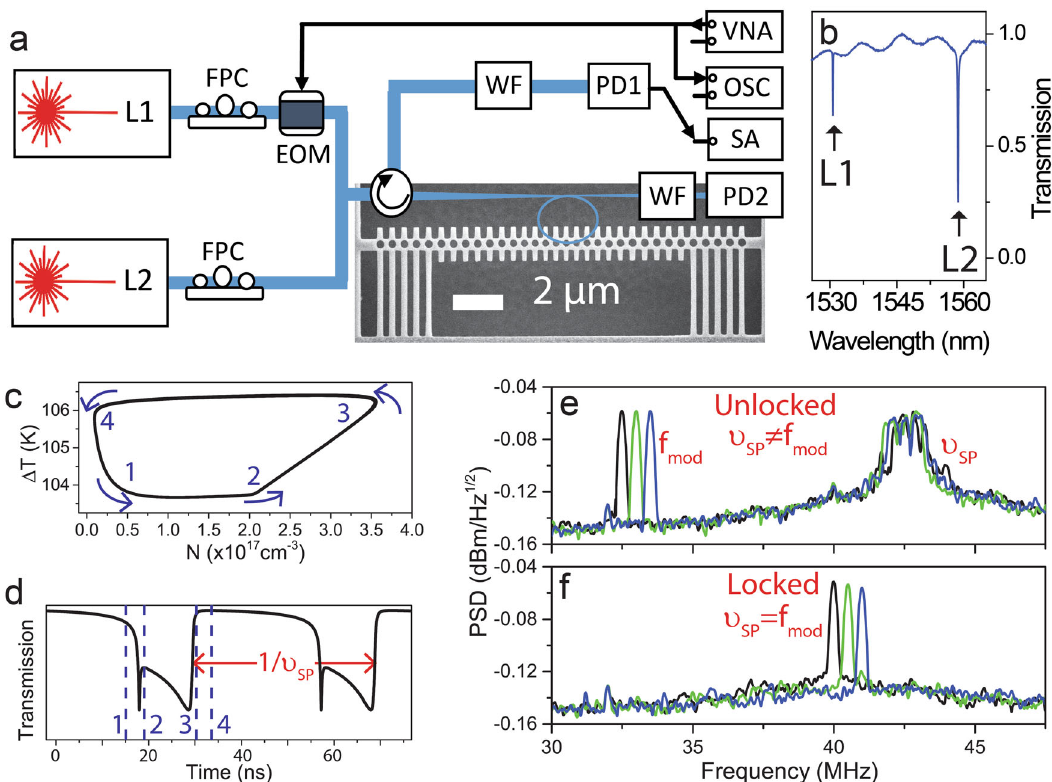
Fig. 1 Experimental setup and principle of operation. a The main optical signals are derived from two external-cavity diode lasers (L1 and L2) and sent into a tapered microloop optical fi ber to evanescently couple light into the silicon optomechanical crystal cavity (OMC). The optical signal decoupled from the OMC is collected by the same fi ber and measured either in transmission or in re fl ection using an in- fi ber circulator. The signals in both arms are band-pass fi ltered by 1 nm bandwidth wavelength fi lters (WF), impinging on two fast photodetectors (PDs). The electrical signals are sent to a spectrum analyzer (SA), a vector network analyzer (VNA) or an oscilloscope (OSC) for characterization. EOM stands for electro-optic modulator and FPC for fi ber polarization controller. b Optical transmission spectrum, exhibiting two optical modes at λ 1,o = 1531 nm and λ 2,o = 1559 nm. Lasers L1 and L2 address the fundamental and fi rst order modes respectively, L1 acting as the pump and L2 as the probe. c Self-pulsing (SP) limit-cycle represented in the phase space de fi ned by the effective temperature increase of the cavity region ( Δ T) and the free carrier concentration (N) d Time trace of the transmitted optical signal when SP is active. The positions highlighted by numbers 1 – 4 are associated to the different corners of the SP limit-cycle of panel c . e and f Power spectral density (PSD) spectra when the system is in a SP state and the modulation is on ( P mod = ±6.1%) at different modulation frequencies. In panel e the SP limit- cycle is not locked to the external modulation ( f mod ~33 MHz and υ SP ~43 MHz), while it is locked in panel f ( f mod = υ SP ~41